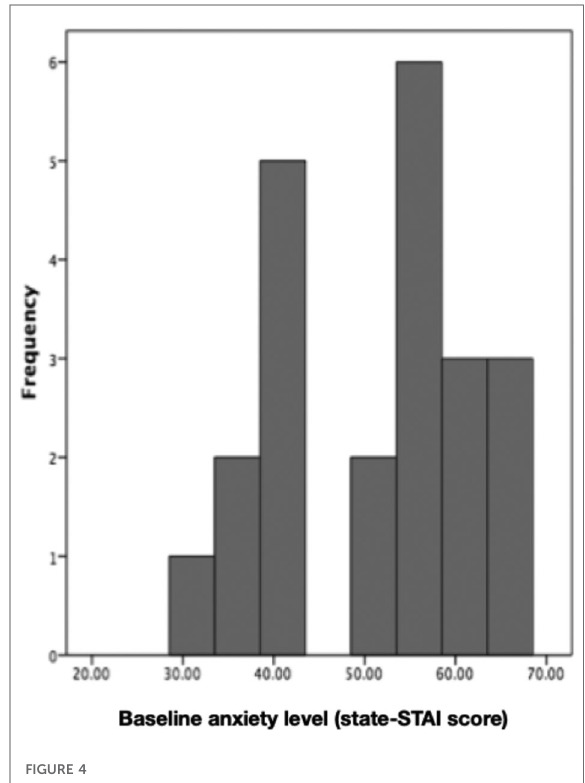
FIGURE 4 The fi gure depicts baseline anxiety levels of participants.